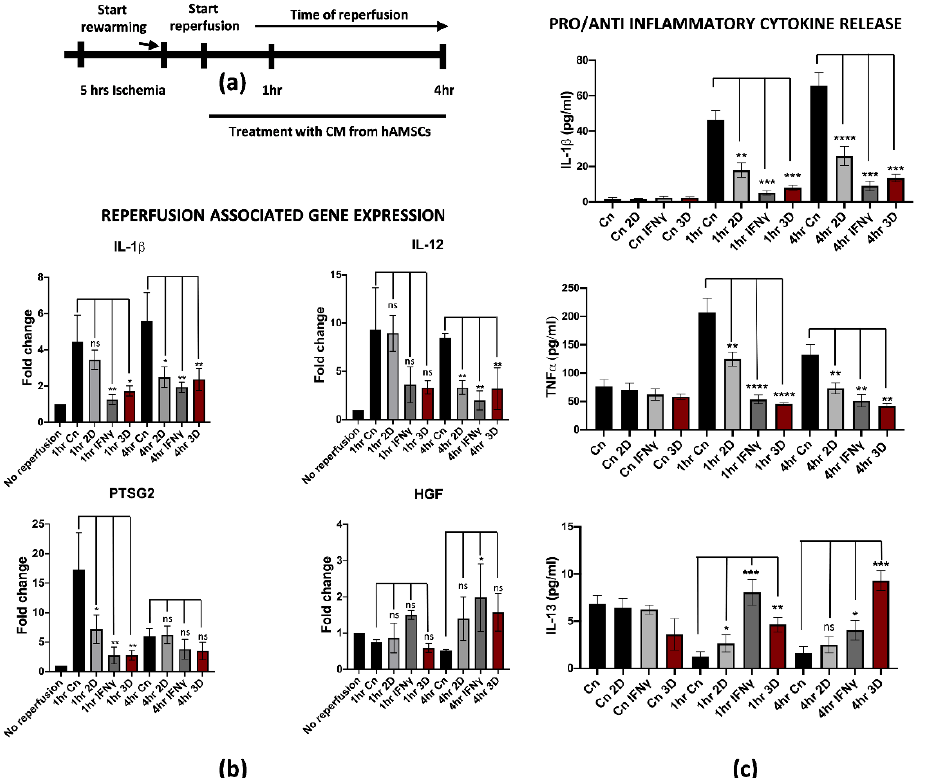
Figure 4. hAMSCs conditioned medium attenuates inflammation in reperfused M1-like macrophages. ( a ) Schematic representation of the modified IRI protocol applied to M1-like macrophages. ( b ) Gene expression analysis of pro-inflammatory genes in reperfused M1-like macrophages treated at different timepoints with pre-conditioned CM from hAMSCs. The comparison has been conducted by using the ∆∆ CT method and normalized to GAPDH transcript. Statistical significance has been calculated via ordinary one-way ANOVA (Dunnet’s multiple comparisons test, n = 3, * = p < 0.05; ** = p < 0.005; ns = not significant). ( c ) IL-1 β and TNF α and IL-13 protein quantification in the conditioned medium of reperfused M1-like macrophages treated at different timepoints with pre-conditioned CM from hAMSCs. Protein concentration has been calculated according to the standard curve of each ELISA assay ( n = 3). Statistical significance has been calculated via ordinary one-way ANOVA (Dunnet’s multiple comparisons test, n = 3, * = p < 0.05; ** = p < 0.005; *** = p < 0.0005; **** = p < 0.0001; ns = not significant). The statistical analyses have been performed by comparing 1 h and 4 h Cn (black histograms) vs. the samples at the same timepoints treated with preconditioned CM- hAMSCs.